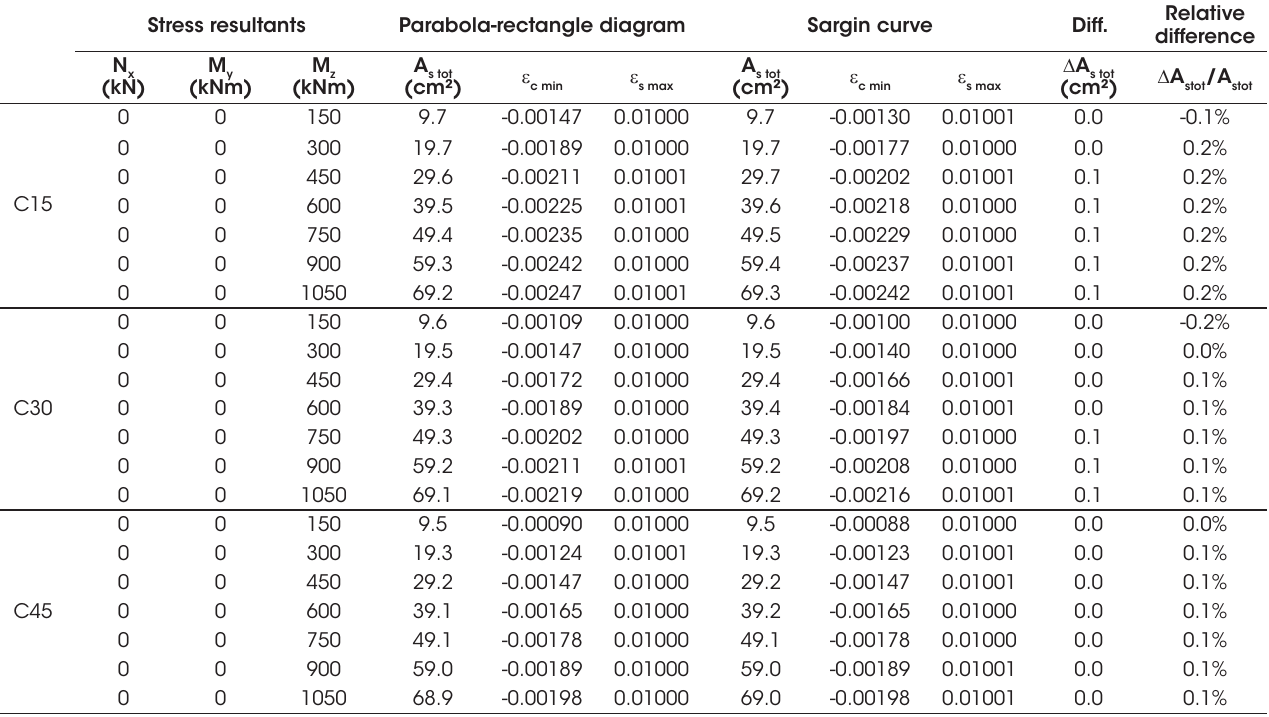
Doubly-reinforced cross-section subjected to pure bending Stress resultants Parabola-rectangle diagram Sargin curve Diff.